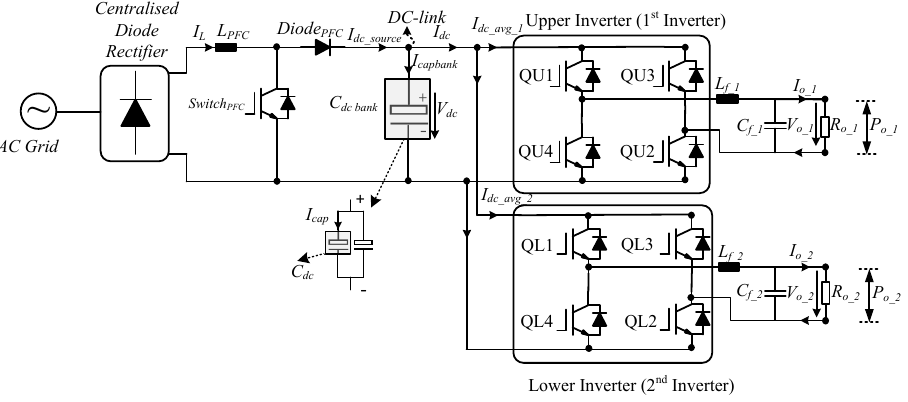
Figure 2. Schematic of the multi-converter system with individual DC-banks.